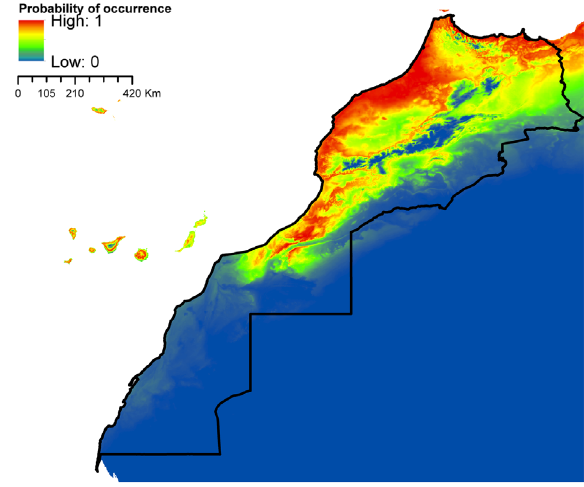
Figure 3. Predicted probability of Ae. albopictus occurrence in Morocco.